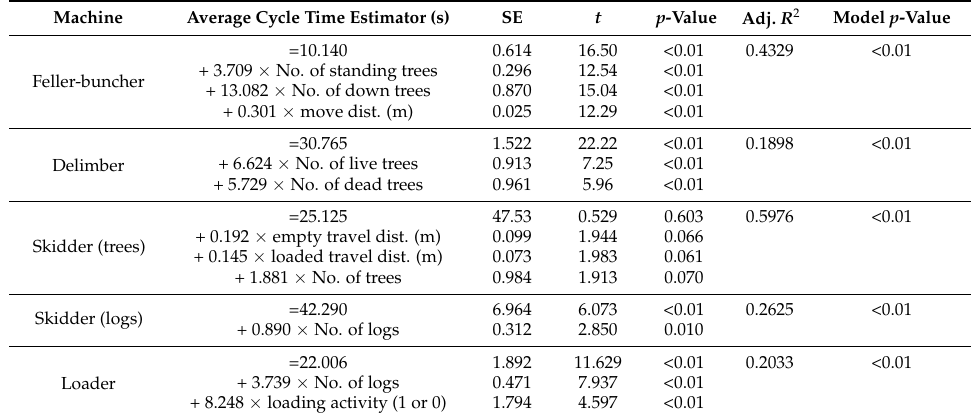
Table 5. Delay-free cycle time regression models for individual machines used in whole-tree harvesting (adopted from